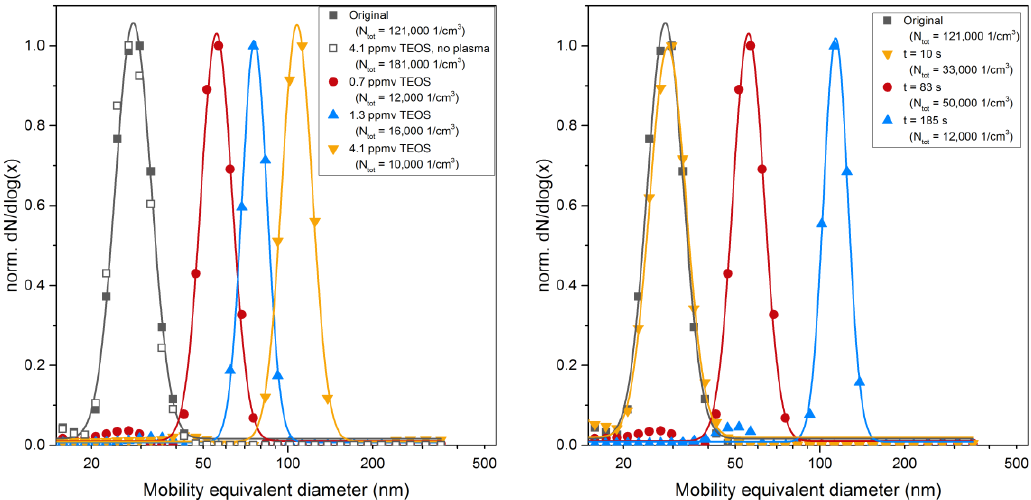
Figure 4. Mobility equivalent diameter measured with scanning mobility particles sizer (SMPS): ( left ) as a function of the tetraethyl orthosilicate (TEOS) concentration at constant reaction time t Reaction = 83 s; and ( right ) as a function of reaction time at constant TEOS concentration of 0.7 ppmv (the total number concentration N tot is given in the legend). Table 3. Elemental composition from the quantitative energy-dispersive X-ray spectroscopy (EDX) analysis as a mean of several measurements on the samples for two different reaction